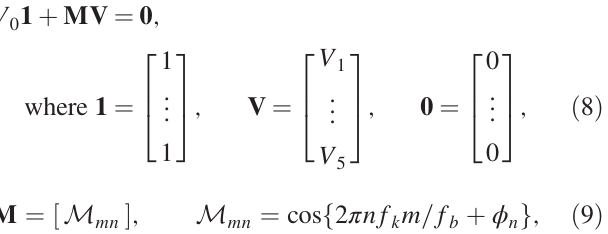
Table II). The corresponding temporal profile is shown in Fig. 3(a).